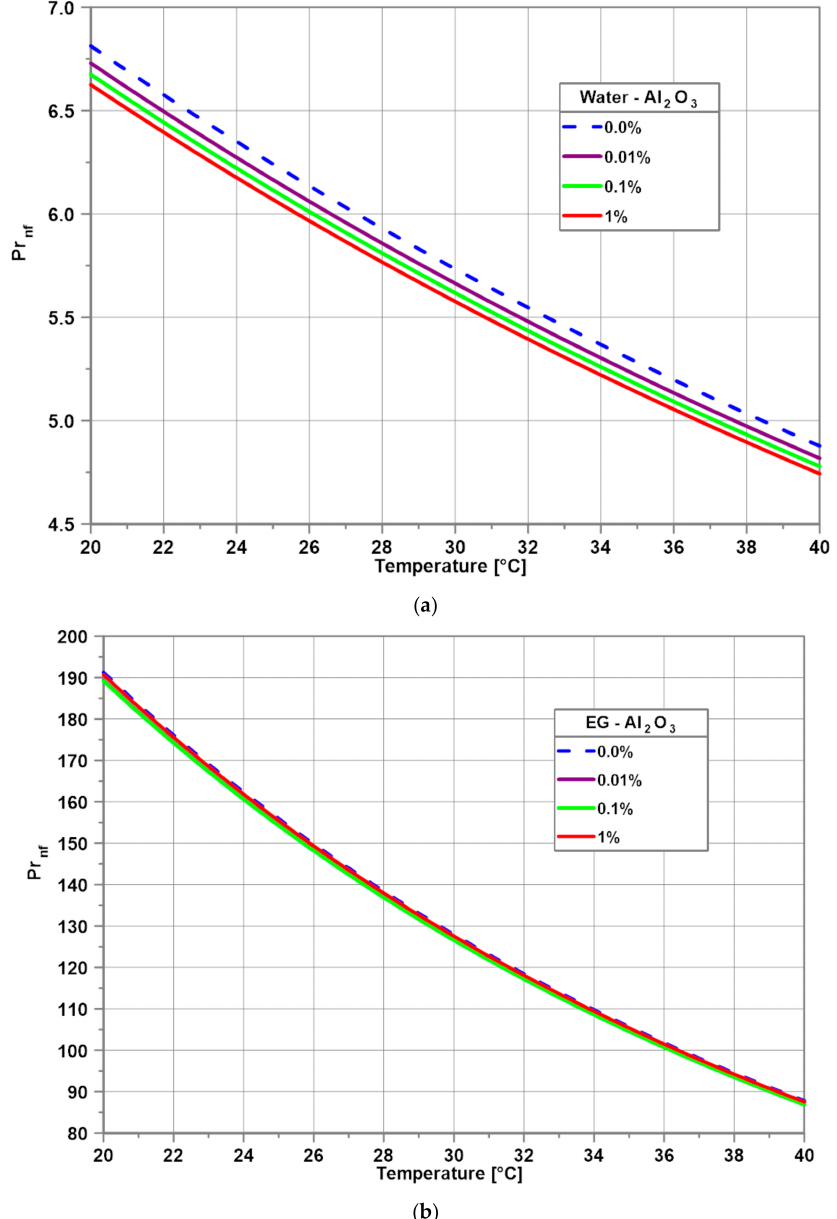
Figure 6. Prandtl number water-based ( a ) and EG-based ( b )